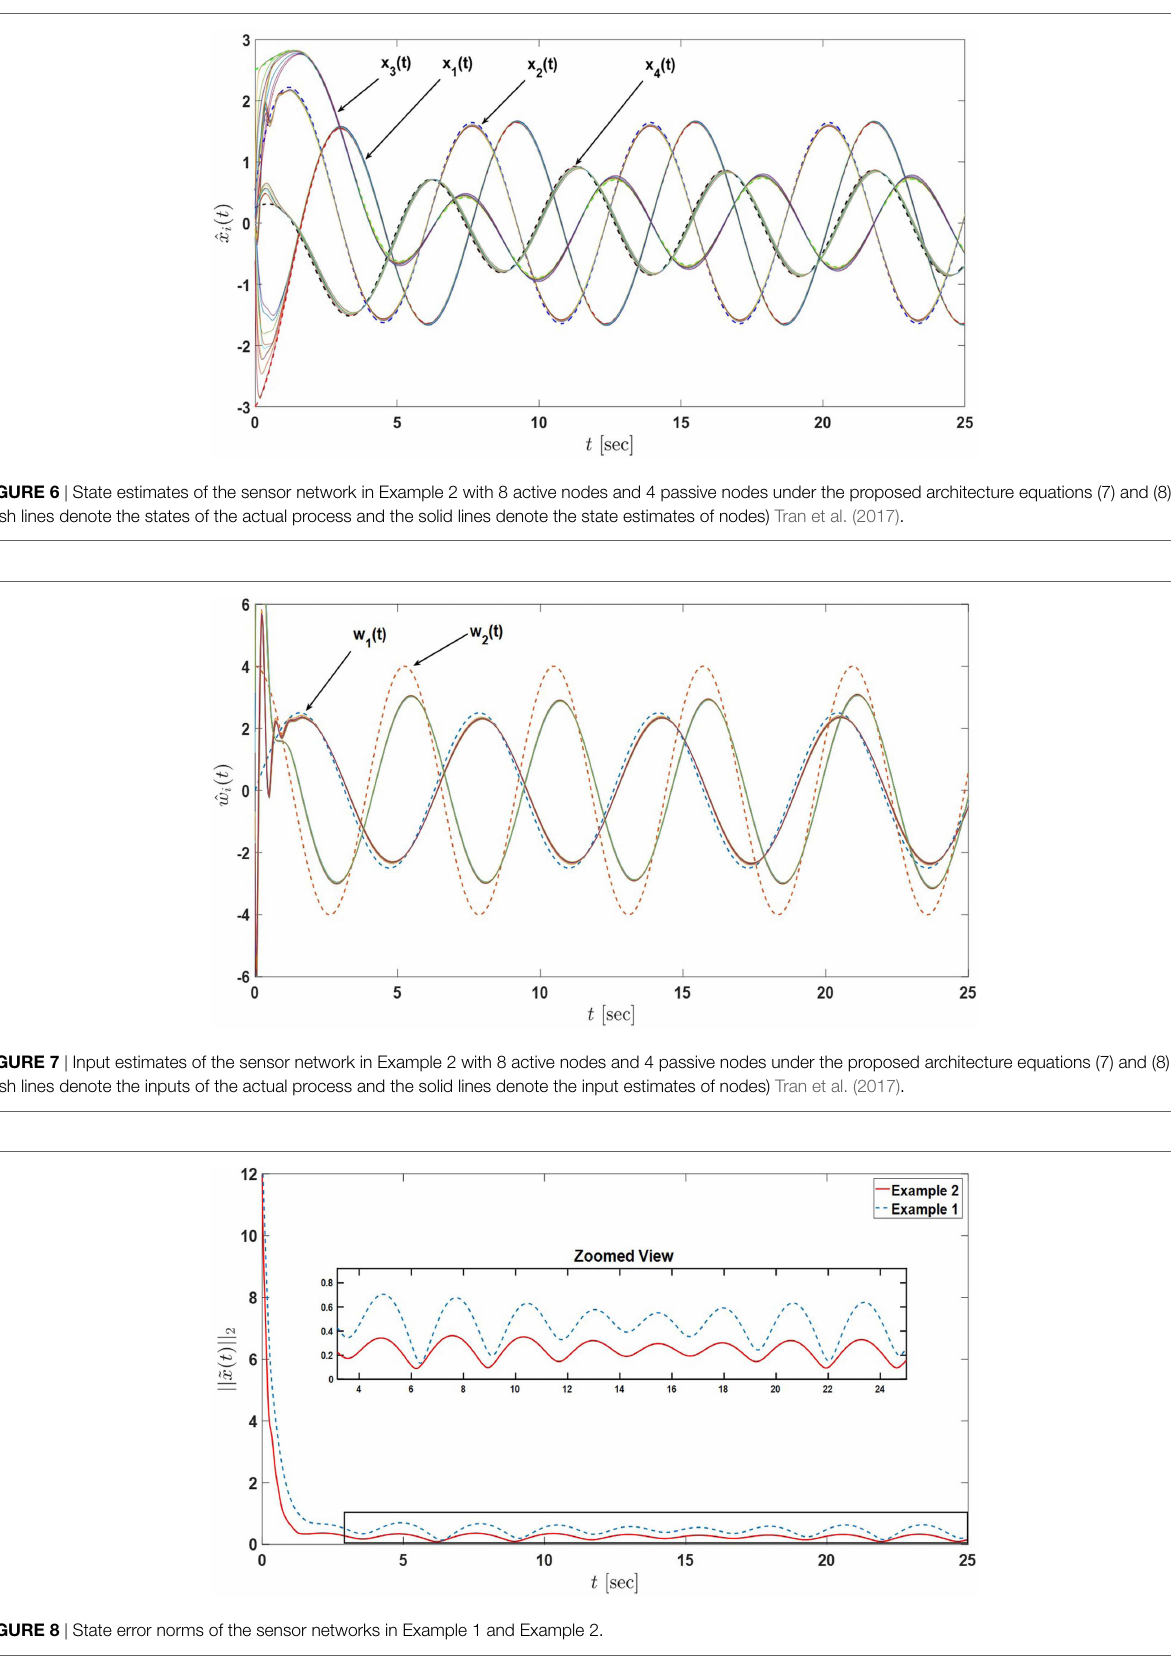
Frontiers in Robotics and AI |